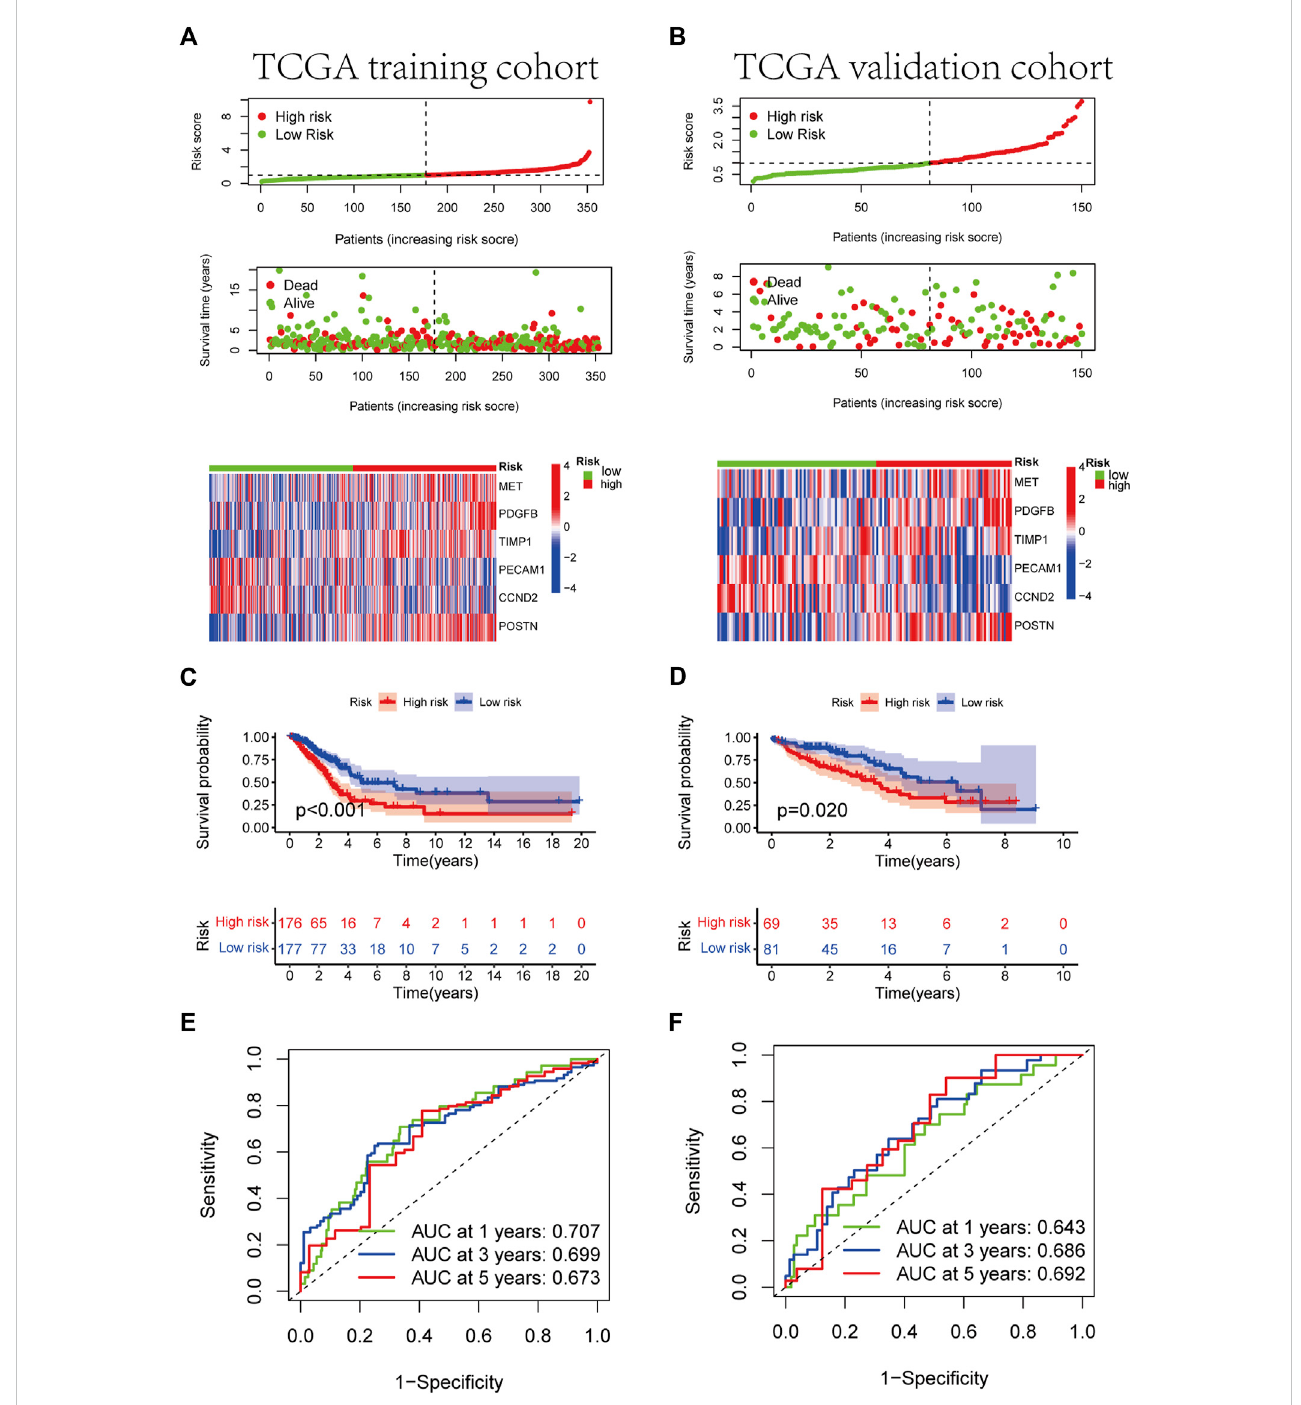
FIGURE 5 Development of RS based on the 6 ARGs signature of patients with LUAD in the TCGA training and TCGA validation cohorts. (A, B) The heatmap of the 6 ARGs expression pro fi les between the high-risk and low-risk groups in the training or validation cohort, together with the RS distribution and patient vital status. (C, D) Kaplan-Meier analysis of the prognostic model in training or validation cohort. (E, F) The ideal AUC of the gene signature in the two cohorts was determined using a time-dependent ROC